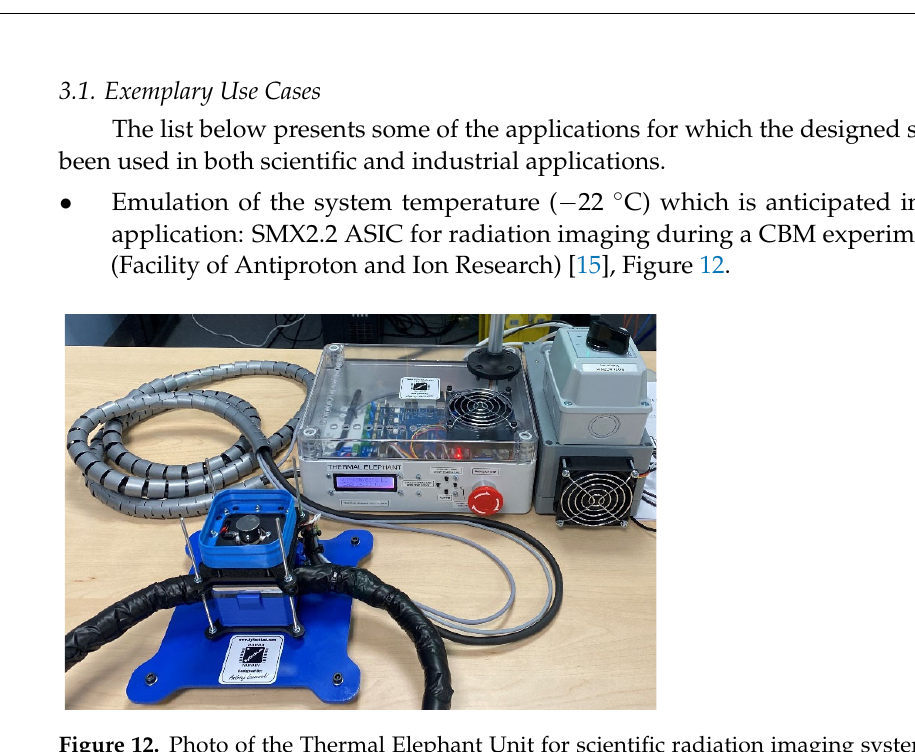
9 of 11 Figure 11. Measured stability of the temperature regulation for heating up to +120 °C ( top ) and cooling down to − 10 °C ( bottom ). 3.1. Exemplary Use Cases The list below presents some of the applications for which the designed solution has been used in both scientific and industrial applications.  Emulation of the system temperature ( − 22 °C) which is anticipated in the target ap ‐ plication: SMX2.2 ASIC for radiation imaging during a CBM experiment at FAIR (Fa ‐